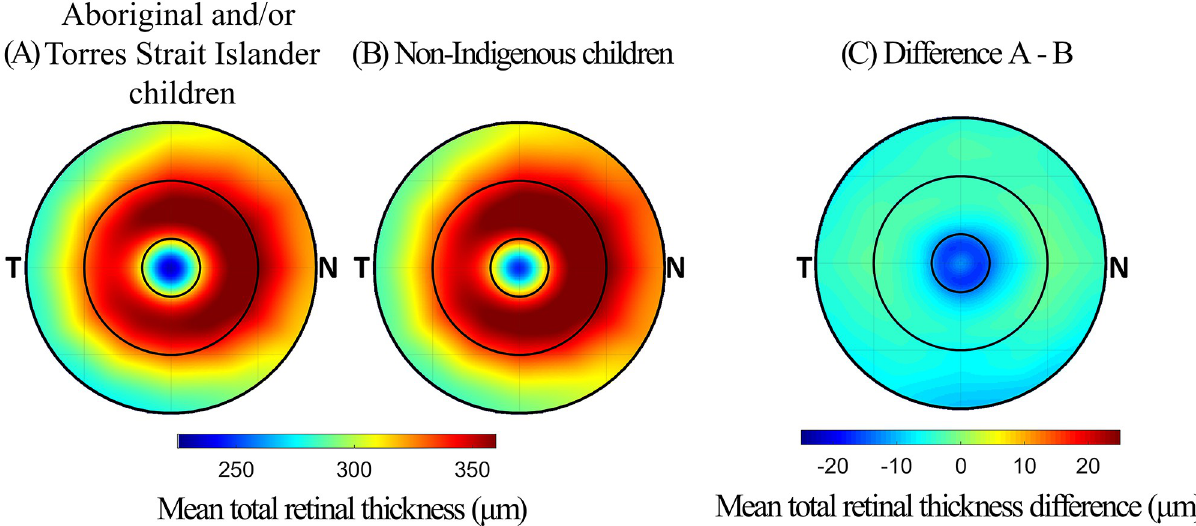
Fig 4. Thickness maps illustrating the mean TRT for (A) Aboriginal and/or Torres Strait Islander children, (B) non-Indigenous children, and (C) the difference between the two groups. Cooler colours (negative values) in the thickness difference map represents a thinner retina among Aboriginal and/or Torres Strait Islander children.